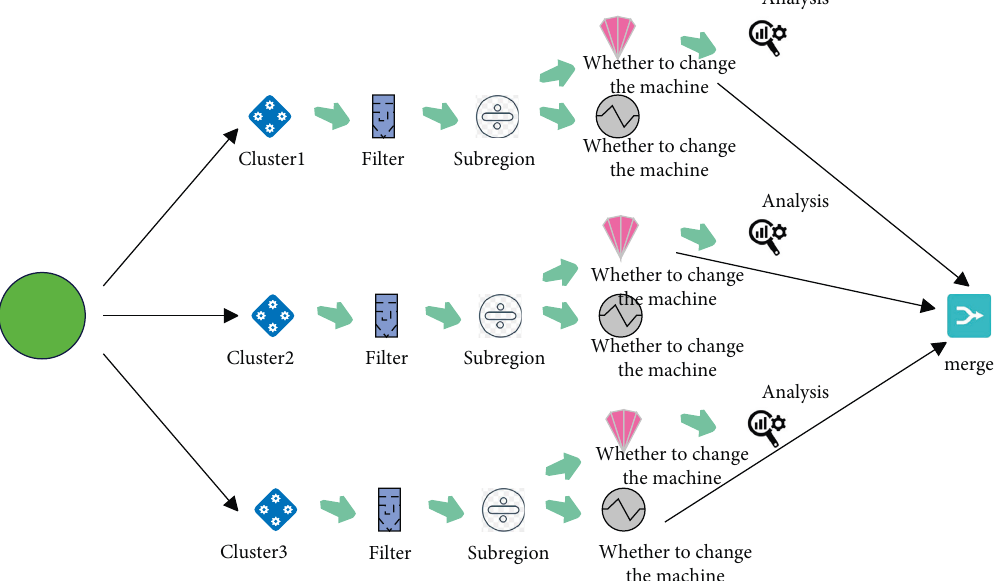
Figure 7: Clustering data modeling.